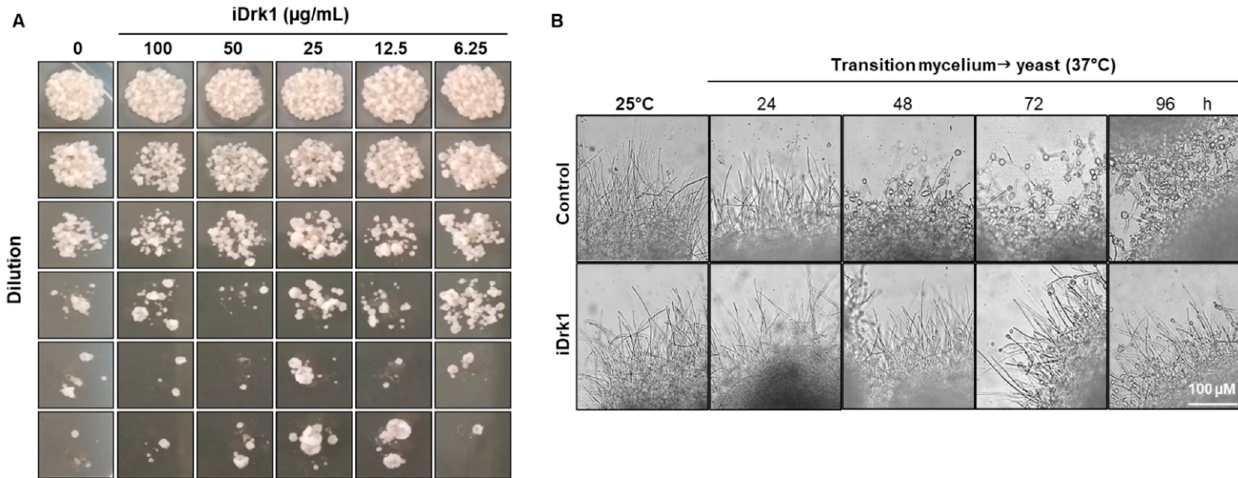
Figure 1. ( A ) Susceptibility of P. brasiliensis yeast cells to Drk1 pathway inhibitor (iDrk). A total of 1 × 10 6 cells/mL were incubated with different concentrations of iDrk1 and incubated for 24 h. Then, the yeasts cells were diluted, plated in solid mYPD medium and incubated in for 7 days at 37 °C. ( B ) Dimorphic transition assay of P. brasiliensis in the presence or not of iDrk1. The fungus was cultivated as mycelial, at 25 °C and 150 rpm. Subsequently, it was plated in 6-well plates and incubated at 37 °C in mYPD medium supplemented or not with 20 µM iDrk1. Cultures were monitored every 24 h and observed under an optical microscope to evaluate the dimorphic transition.